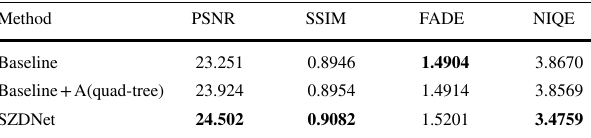
Table 5 Quantitative comparison between the proposed SZDNet and the other two